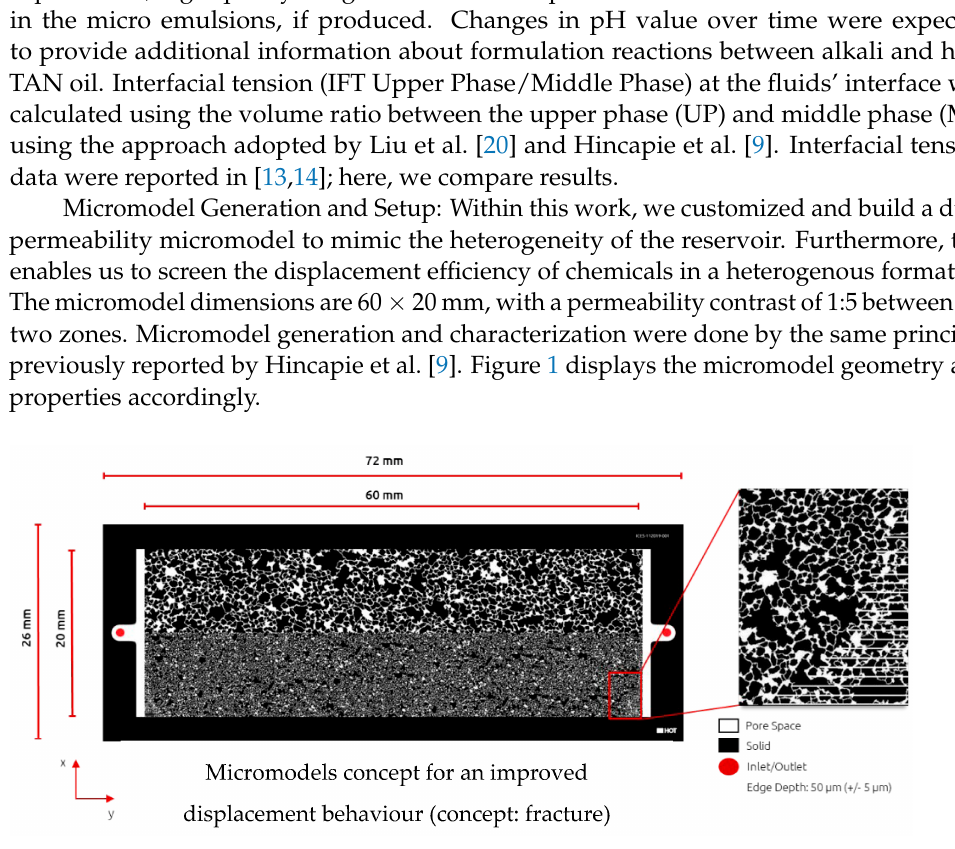
Figure 1. Illustration of the heterogenous micromodel used in this work. Top: high-permeability zone; Bottom: low-permeability zone.